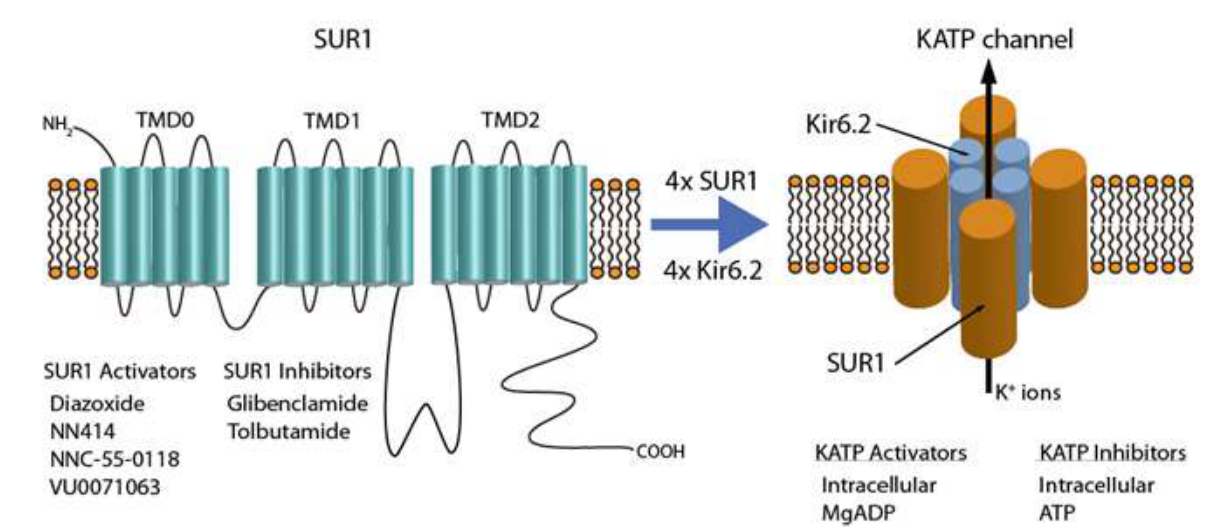
Figure 2. Simplified schematic representation of the SUR1 subunit and KATP channel; key inhibitors and activators of SUR1 listed.